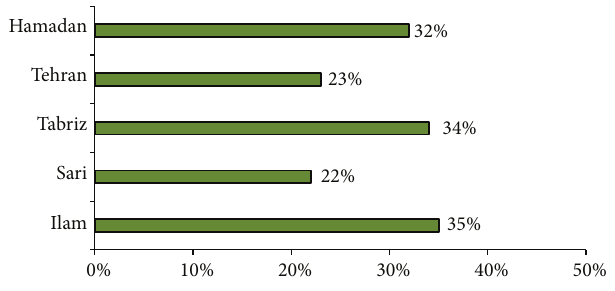
Figure 1: Prevalence of PPD in different cities in Iran.